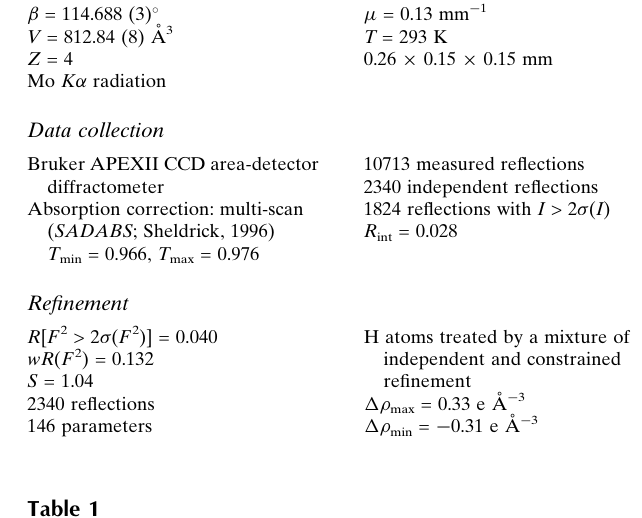
Hydrogen-bond geometry (A˚ , (cid:3) )